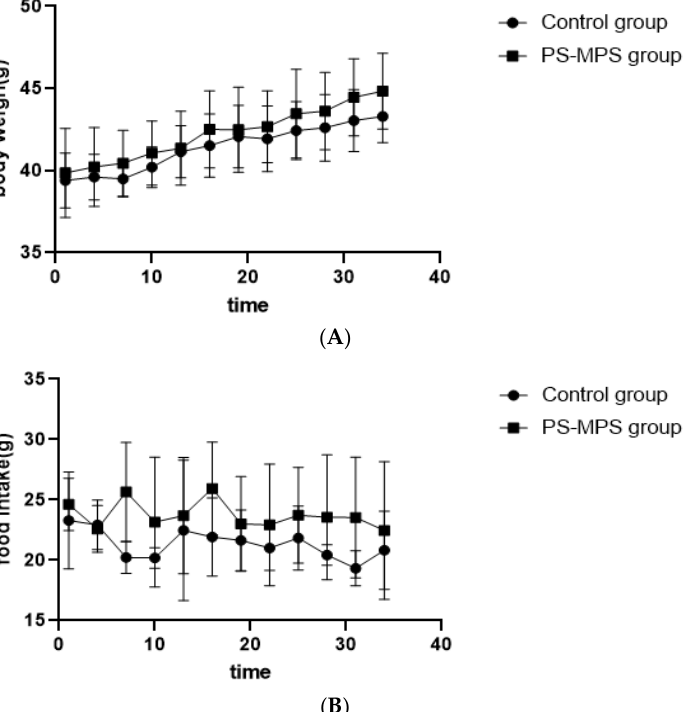
Figure 1. Body weight, food intake and organ coefficient of mice during the exposure period. ( A ) Body weight of mice; ( B ) Food intake of mice. The data are expressed as the mean ± SD (n = 8) and analyzed by dependent sample t -test.